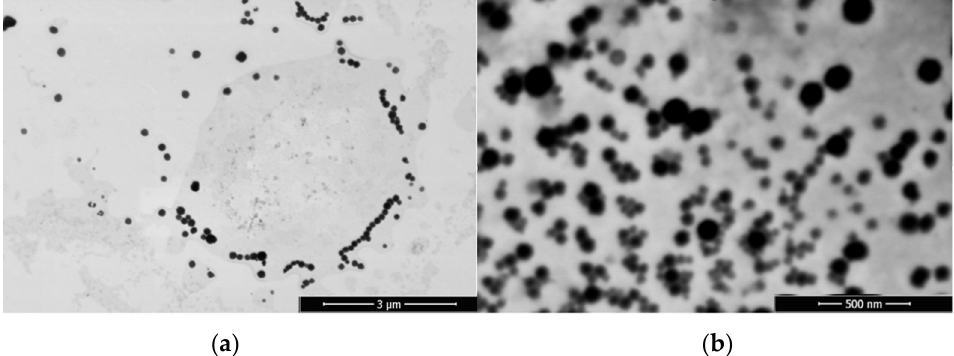
Figure 2. Images of ( a ) nanoemulsion and ( b ) dextran nanocapsules with imiquimod in their core (DX NC-imq*) obtained by scanning electron microscopy (STEM). * Formulation elaborated under pressure.